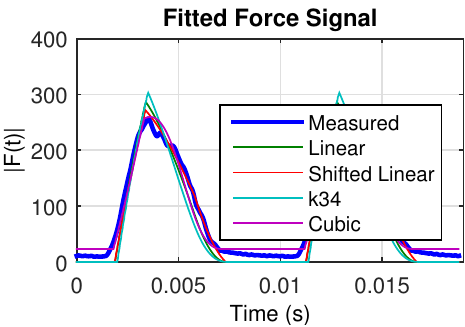
Figure 6. Comparison of various fitted force models and the actual measured force signal.